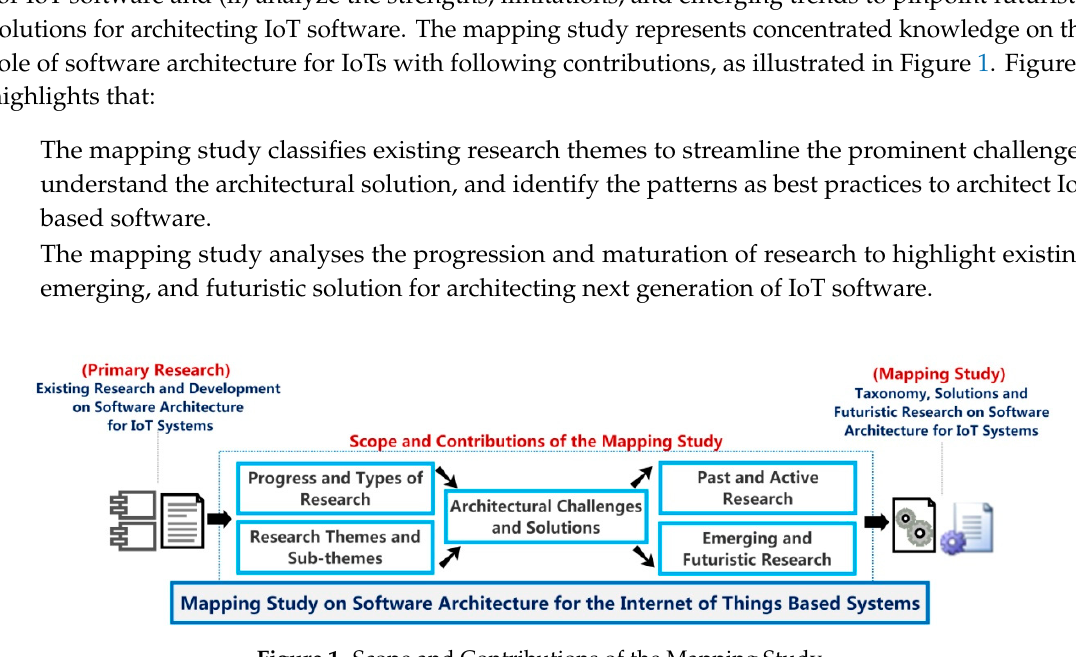
Figure 1. Scope and Contributions of the Mapping Study.